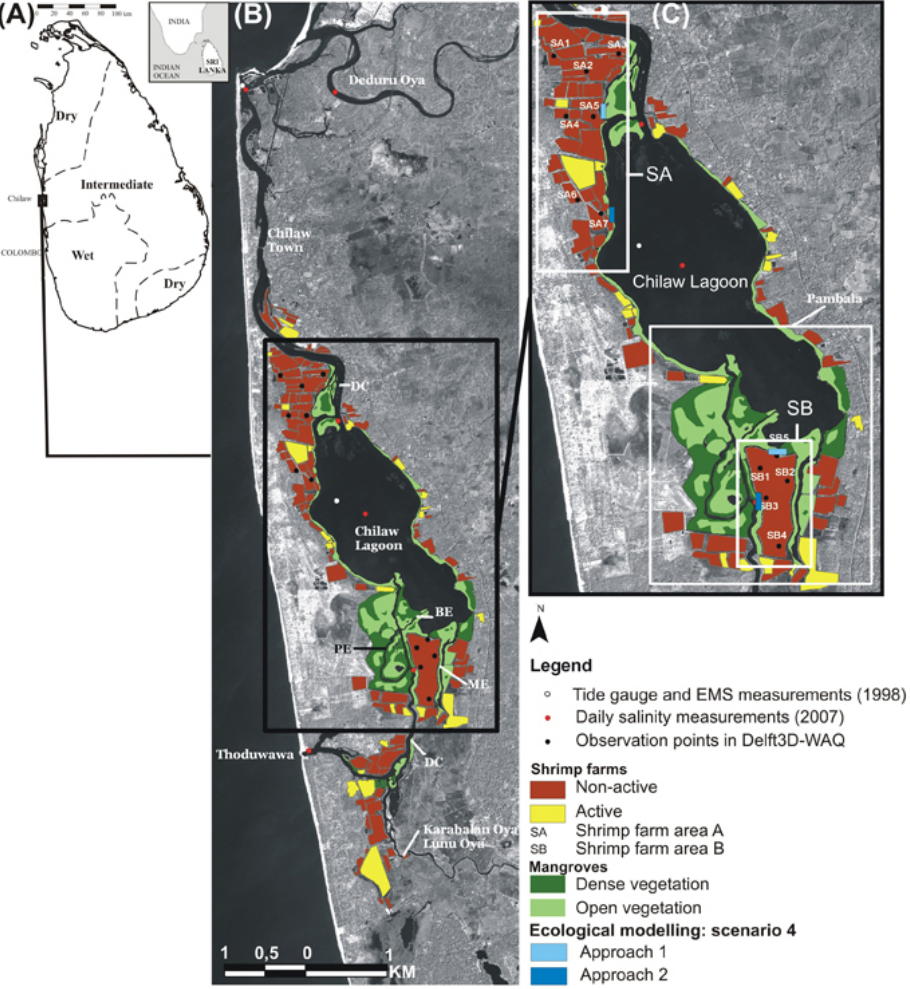
Fig. 1. (A) Representation of Sri Lanka (Dahdouh-Guebas et al., 2000), (B) an IKONOS image (2002) showing the Pambala–Chilaw Lagoon Complex, (C) Indication of the water level and salinity measurements points (both in 1998 and 2007), the observation points in Delft3D- WAQ within shrimp farm area A and B, the active and non-active shrimp farms, the dense and open mangrove vegetation and the channels. Locations of outer dike removal (approach 1 and 2) are also indicated. EMS = Environmental Monitoring System. DC = Dutch Canal, PE = Pol Ela, ME = Marambettiya Ela, BE = Bate